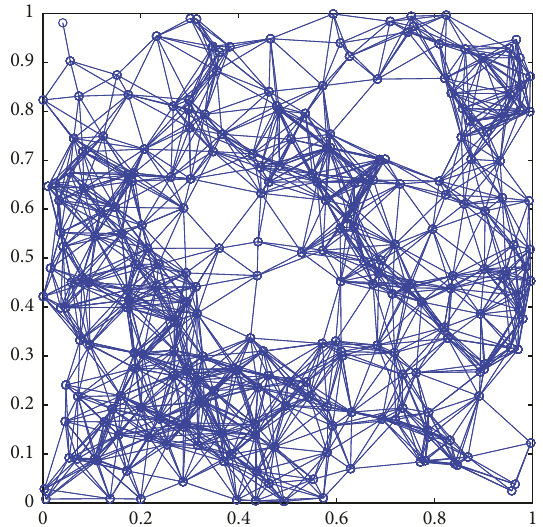
Figure 3: Illustration of a RGG created with 250 nodes embedded into a unit square where the nodes are connected if they are at a Eu- clidean distance smaller than or equal to 𝑅 = 0.15